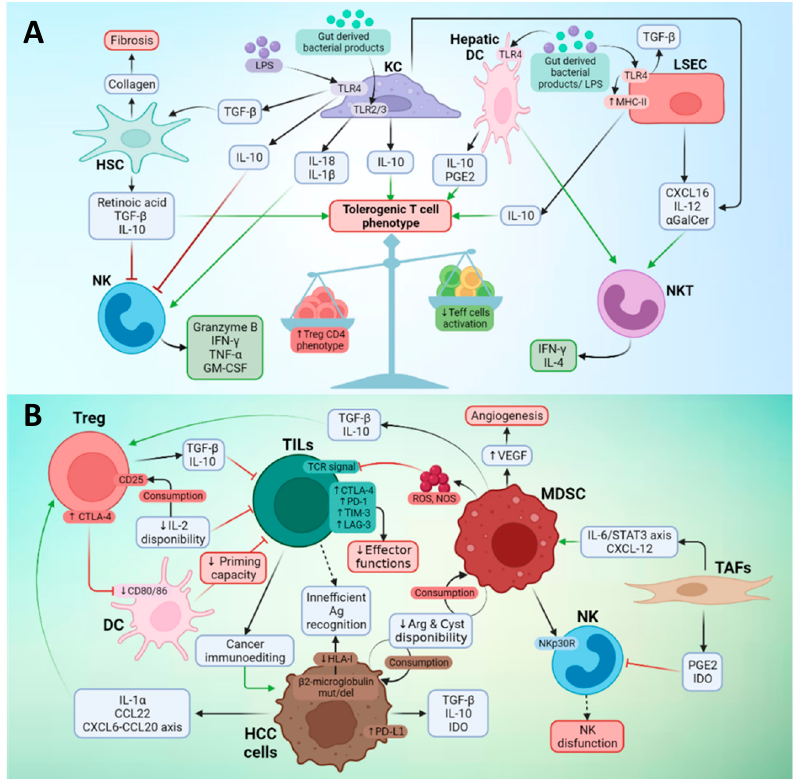
Figure 1. Immune landscape in a healthy liver and in HCC. ( A ) Immune status in liver homeostasis. The liver is constantly exposed to antigens coming from the digestive tract, such as bacterial-derived products and diet nutrients. In this scenario, the liver has different cell subsets that promote a tolerogenic state, formed by the KCs (liver-resident macrophages), LSEC, HSC, and hepatic DCs. These cells are exposed to gut-derived antigens and are stimulated to liberate different soluble factors that (i) favor a tolerogenic phenotype in T cells and (ii) stimulate the innate cell subset, including NKs and NKTs. ( B ) Immune microenvironment in HCC. Tumor cells modulate the immune microenvironment by releasing anti-inflammatory cytokines and altering expression of antigen-presenting molecules. Tumor-associated fibrosis favors recruitment of MDSCs, which liberate proangiogenic VEGF and immunosuppressive TGF- β and IL-10. This immunosuppressive situation (i) promotes an exhausted T cell phenotype in TILs by enhancing inhibitory checkpoint expression and consequently reducing their effector functions, (ii) favors CD4 regulatory T cell activity, and (iii) promotes NK dysfunction. This figure was created using BioRender.